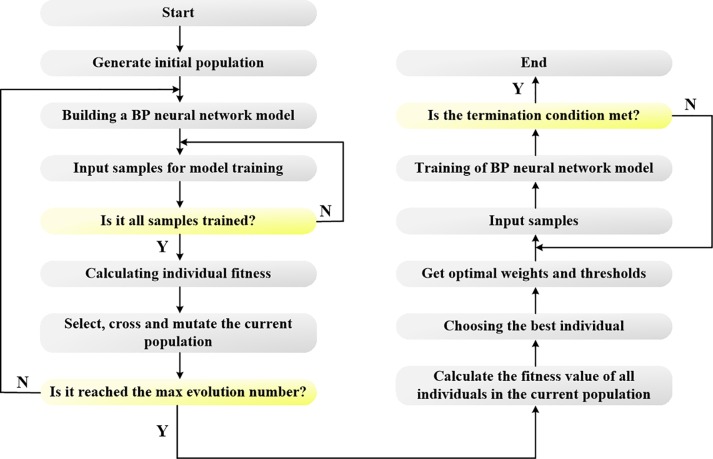
Flow chart of BPNN improved by GA.